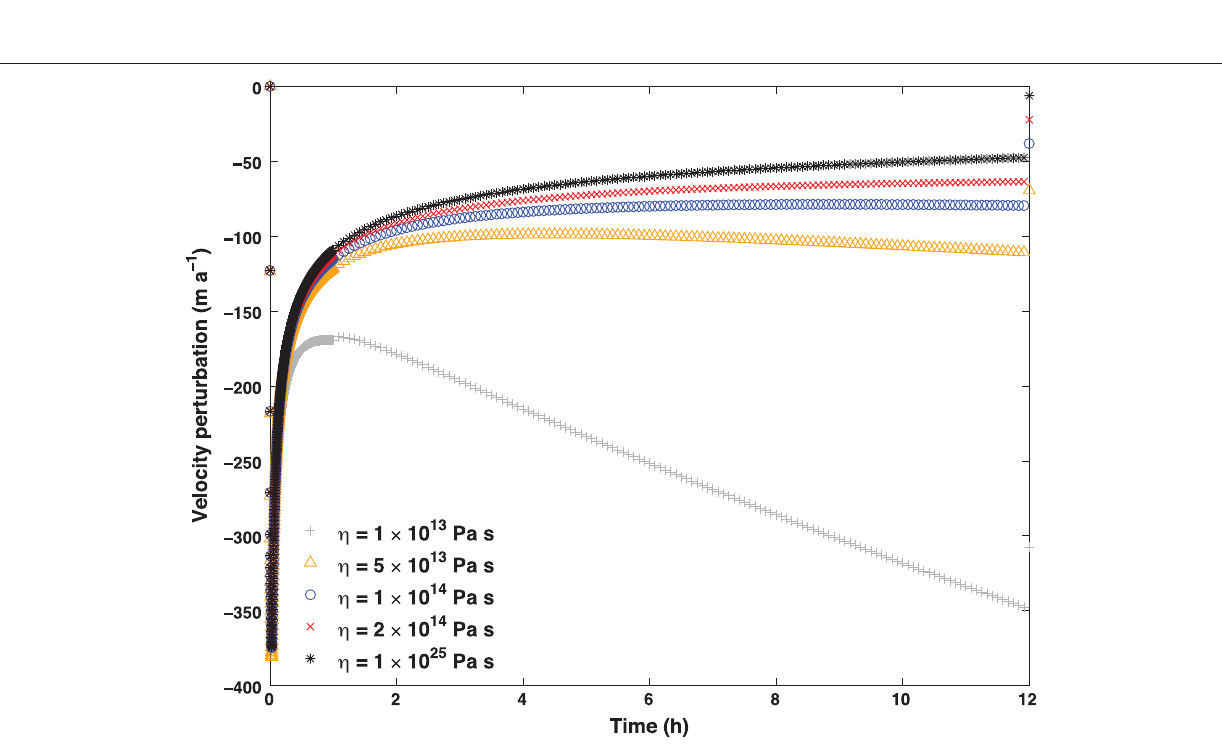
Frontiers in Earth Science | www.frontiersin.org